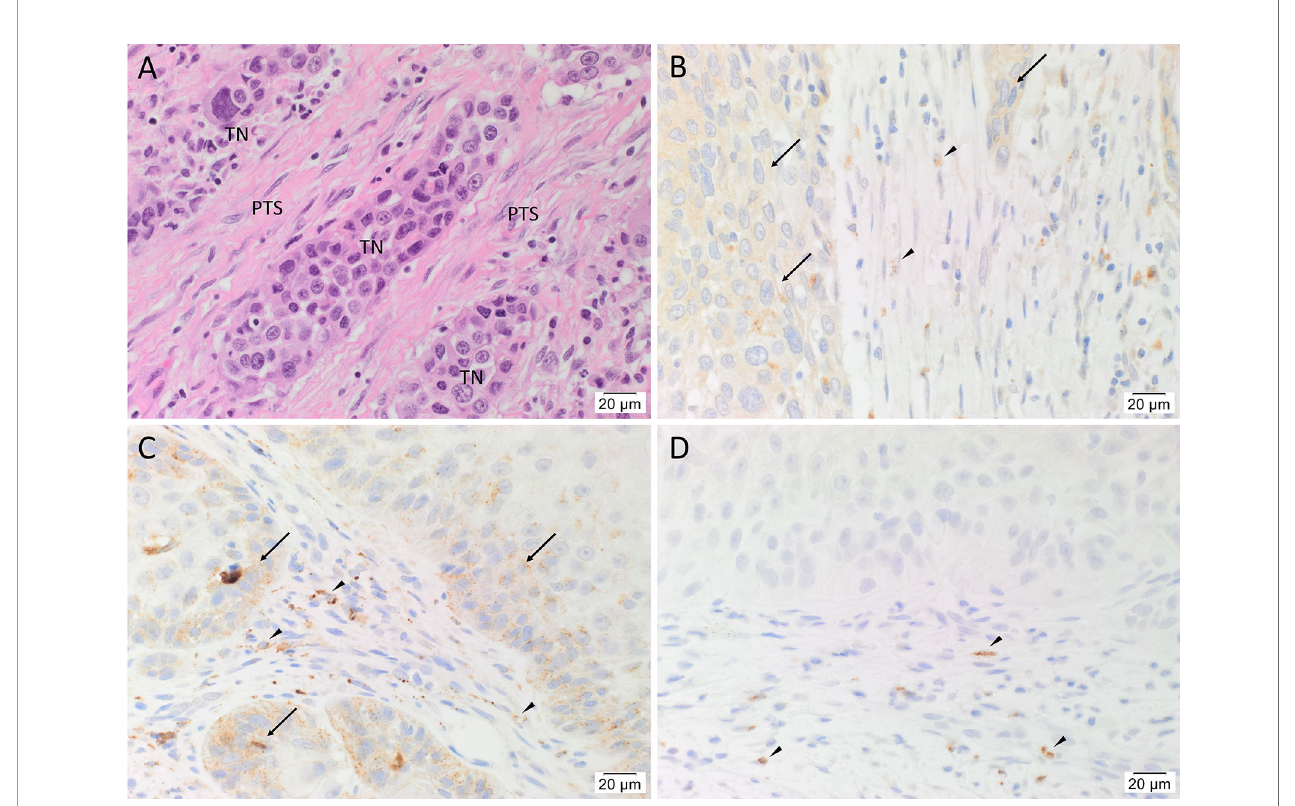
FIGURE 1 | Representative hematoxylin and eosin (A) and immunohistochemical-stained (B – D) images of metastatic head and neck cutaneous squamous cell carcinoma (mHNcSCC) tissue samples, demonstrating tumor nests (TNs) surrounded by the peritumoral stroma (PTS) (A) . Cathepsin B ( B , brown) and cathepsin D ( C , brown) were expressed on the cytoplasm of cells within the TNs (arrows), and occasional cells within the PTS (arrowheads). Cathepsin G ( D , brown) was expressed by few cells within the PTS (arrowheads). Nuclei were counter-stained with hematoxylin. Original magni fi cation: 400x. Scale bars: 20µm. n =